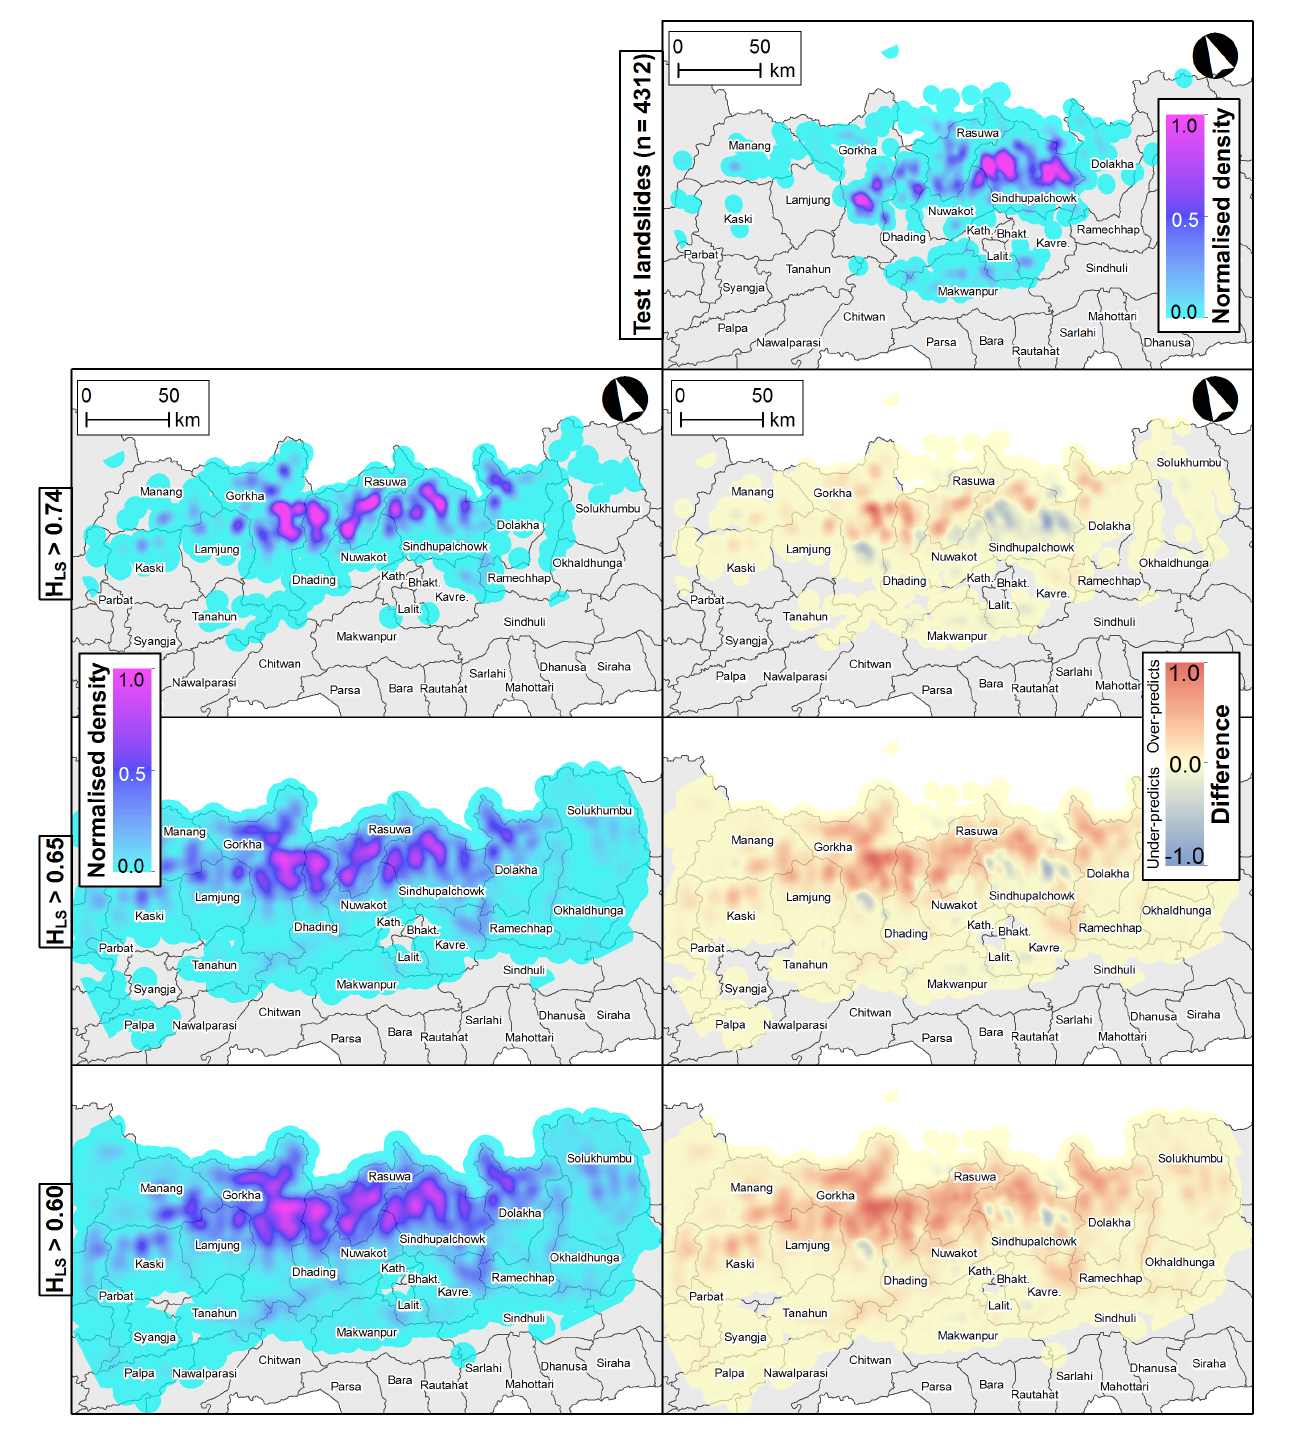
Figure 7. Normalised landslide intensity (number density per unit area) and spatial pattern calculated as kernel density of pixels exceeding various H LS values compared to test landslides for cells with H LS >0.74 (99th percentile), H LS >0.65 (95th percentile), and H LS >0.60 (90th